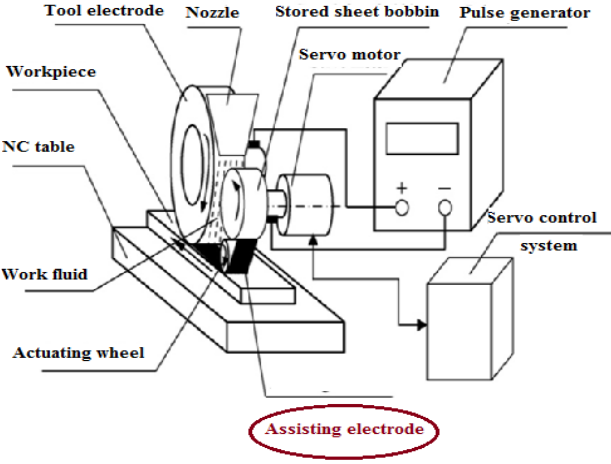
Figure 4: ED milling of nonconductive ceramics [21]